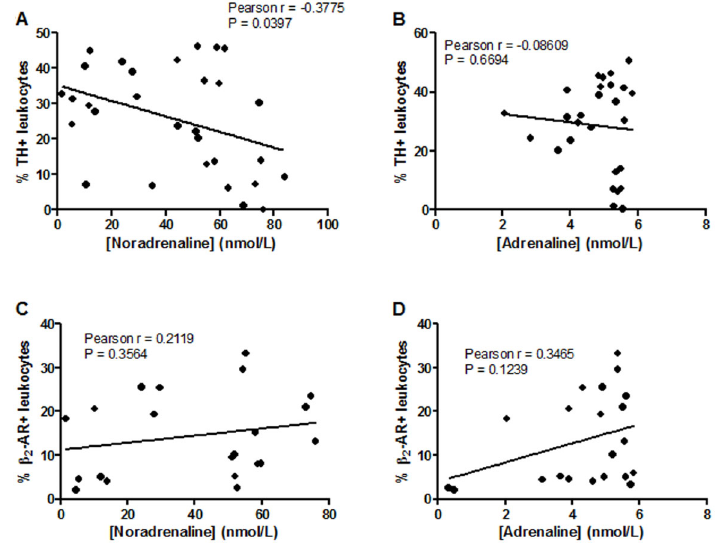
Figure 5. Pearson ’ s correlation between the percentage of leukocytes expressing tyrosine hydroxylase (TH) ( A and B ) or b 2 -adrenergic receptor ( C and D ) ( b 2 -AR) and plasmatic catecholamine